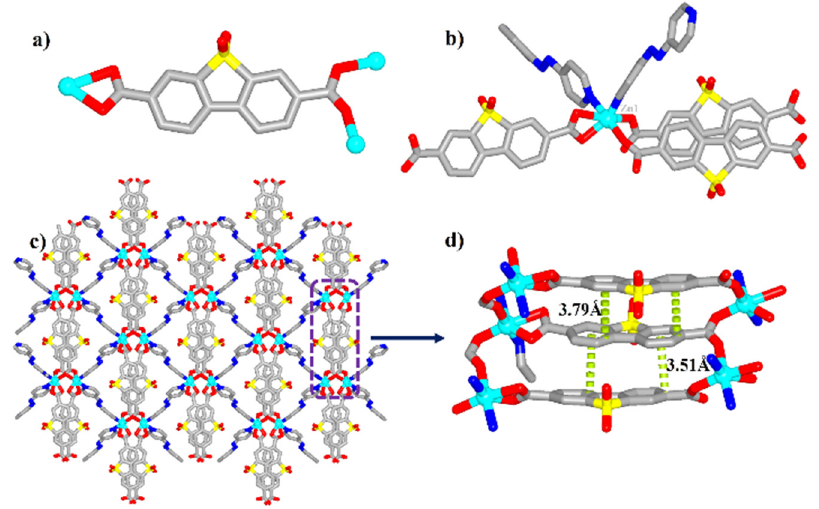
Figure 1. Single-crystal X-ray structure of 1 . Coordination geometry of ligand L1 ( a ); coordination environment of Zn 2+ ions in 1 ( b ); view of the 3D framework of 1 ( c ); view of π ··· π stacking interaction (3.79 Å and 3.51 Å) between L1 ligands ( d ).